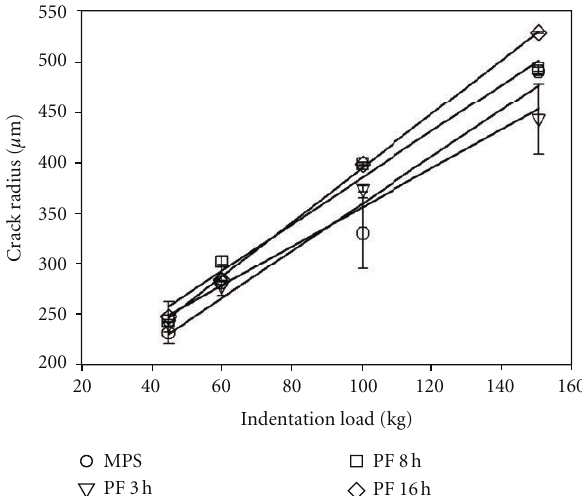
Figure 4: Crack radius versus indentation load